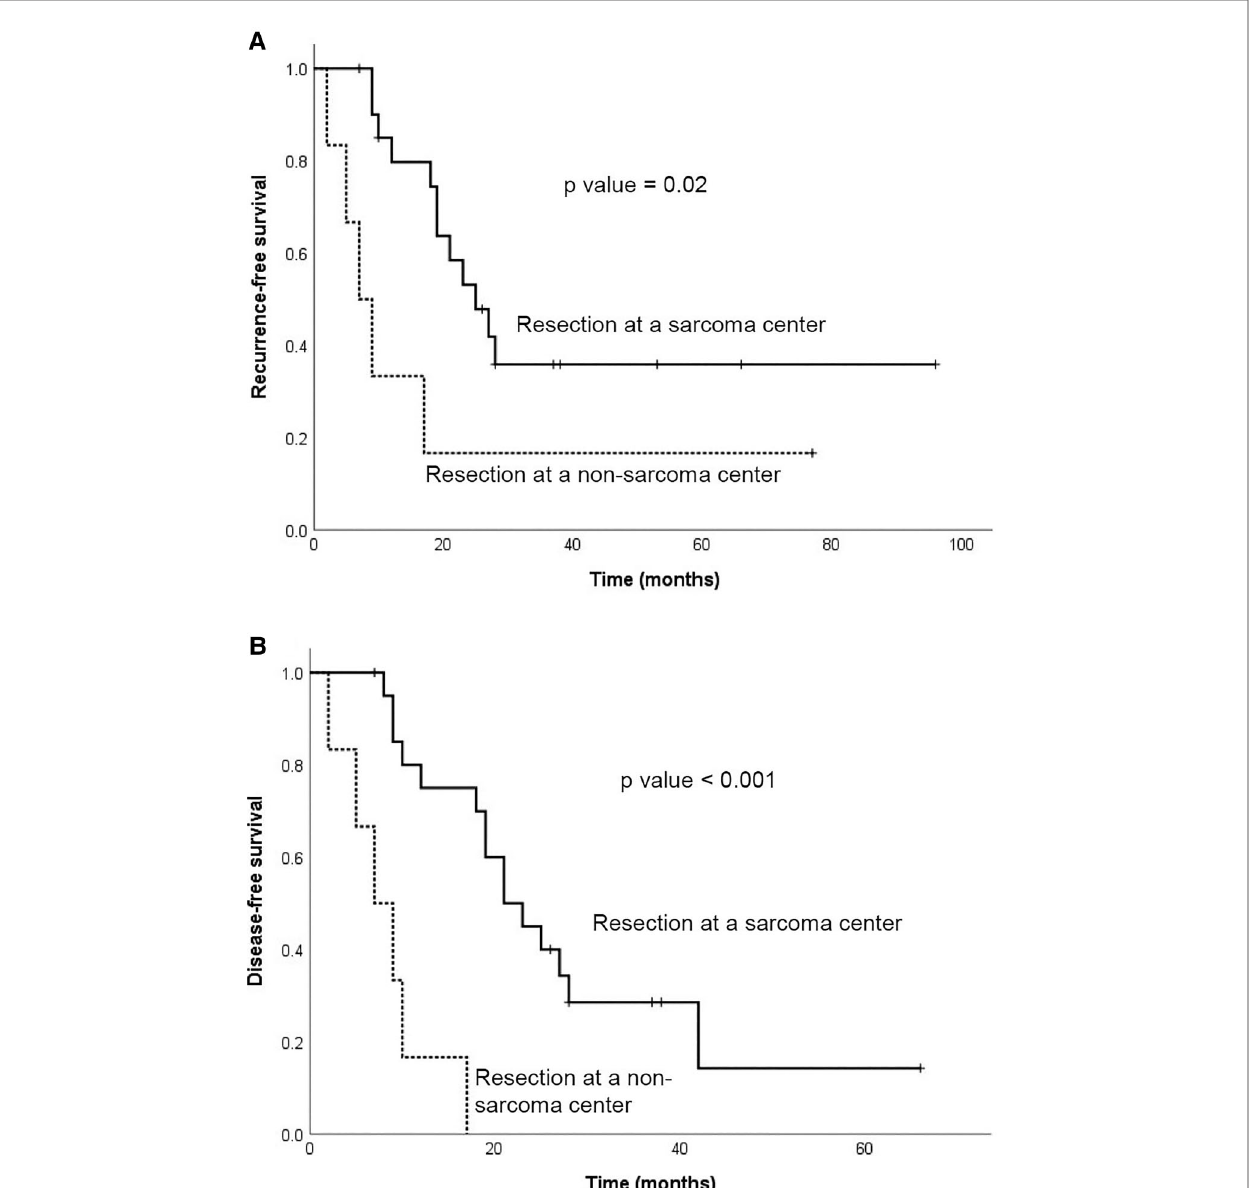
Figure 2 | Kaplan-Meier curve for ( A ) recurrence-free survival and ( B ) disease-free survival after R0/1 resection according to the type of hospital where the resection was performed (sarcoma center vs non-sarcoma center).